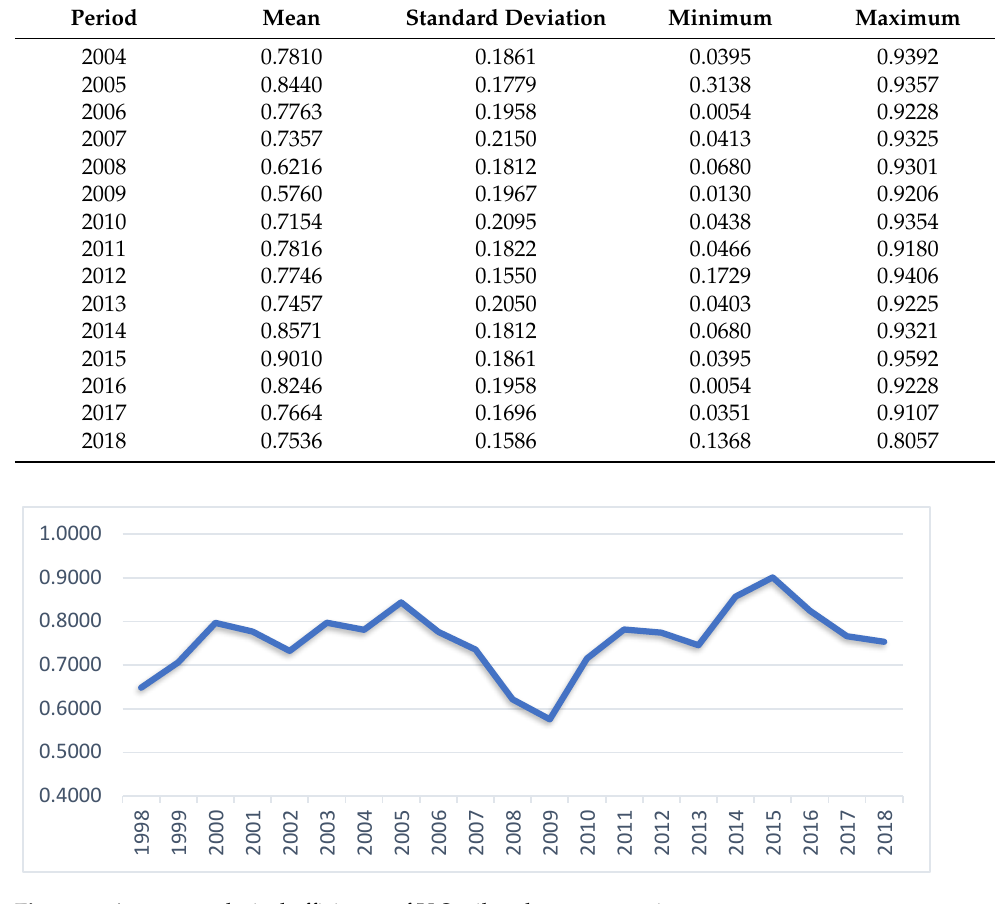
Figure 1. Average technical efficiency of U.S. oil and gas companies.